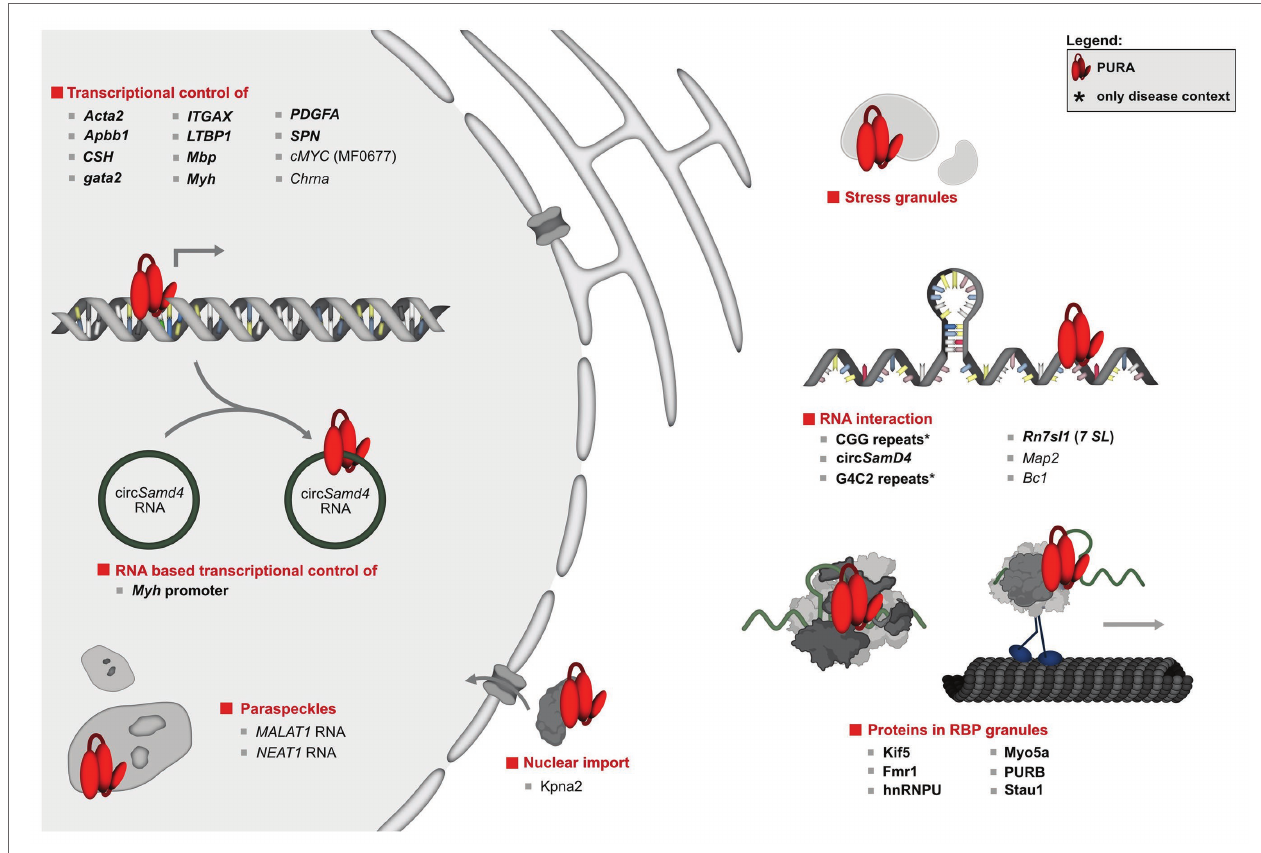
FIGURE 3 | Overview of the molecular pathways of PURA and its known interactions. To date, the only protein interaction of PURA for which experimental evidence indicates a direct binding event is KIF-5 (marked in bold type). DNA and RNA targets that were confirmed by in vitro binding as well as by functional assays or direct correlation with observed effects in animal model organisms were considered to be validated targets (marked in bold letters). They include the human CD43 gene promoter (Shelley et al., 2001; Da Silva et al., 2002), FE65 promoter (Zambrano et al., 1997), Gata2 promotor region in zebrafish (Penberthy et al., 2004), MB1 regulatory region of the MBP gene (Haas et al., 1995), Mhc promoter (Gupta et al., 2003; Ji et al., 2007; Pandey et al., 2020), ovine placental lactogen promotor (Limesand et al., 2004), TGF-ß1 (Thatikunta et al., 1997; Knapp et al., 2006), and the VSM-alpha actin promoter (Knapp et al., 2006). Previously described DNA and RNA interactions of PURA were considered to be only candidate targets if direct binding had been shown either by in vitro experiments or by high-throughput analyses, but where further functional verification is lacking. Those candidate targets are displayed in regular type and include the A-ß-PP (Darbinian et al., 2008), the cMyc upstream promoter region MF0677 (Bergemann and Johnson, 1992; Jurk et al., 1996; Ding et al., 1997; Graebsch et al., 2009; Weber et al., 2016), nAch receptor (Du et al., 1997), and TNF-alpha (Darbinian et al., 2001b). Although for the latter, a reporter assay has been published, this was done only as duplicate and lacked statistical analyses. For simplicity reasons, interaction partners shown in this figure constitute a selection. A complete list of all reported interacting partners is shown in Figure 4